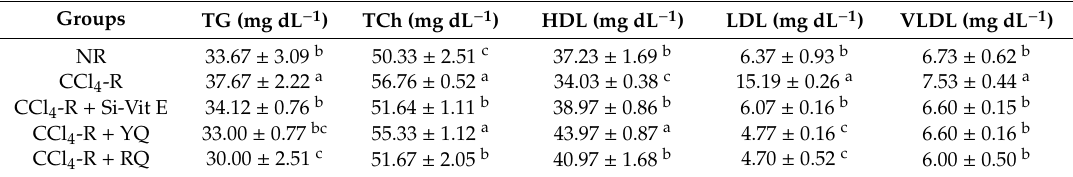
Table 5. E ff ects of quinoa extracts on blood lipids profile of rats with CCl 4 -induced oxidative stress (mean ± SE), n = 6.